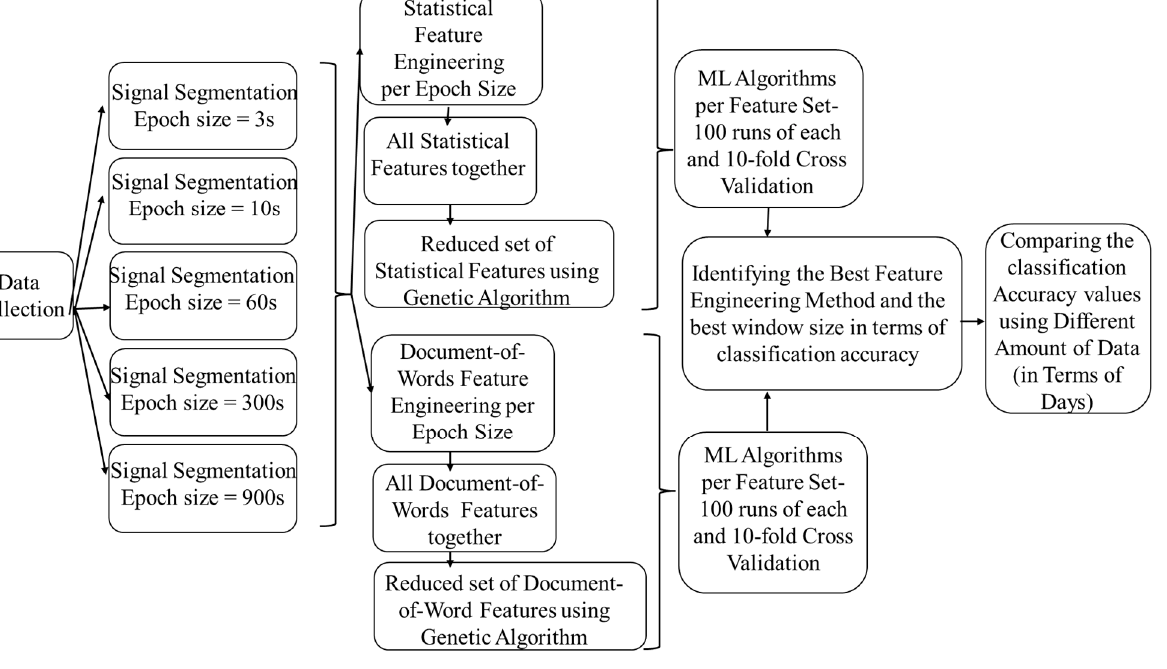
Figure 1. Steps to identify the best feature engineering method and the best windowing strat- egy/strategies.